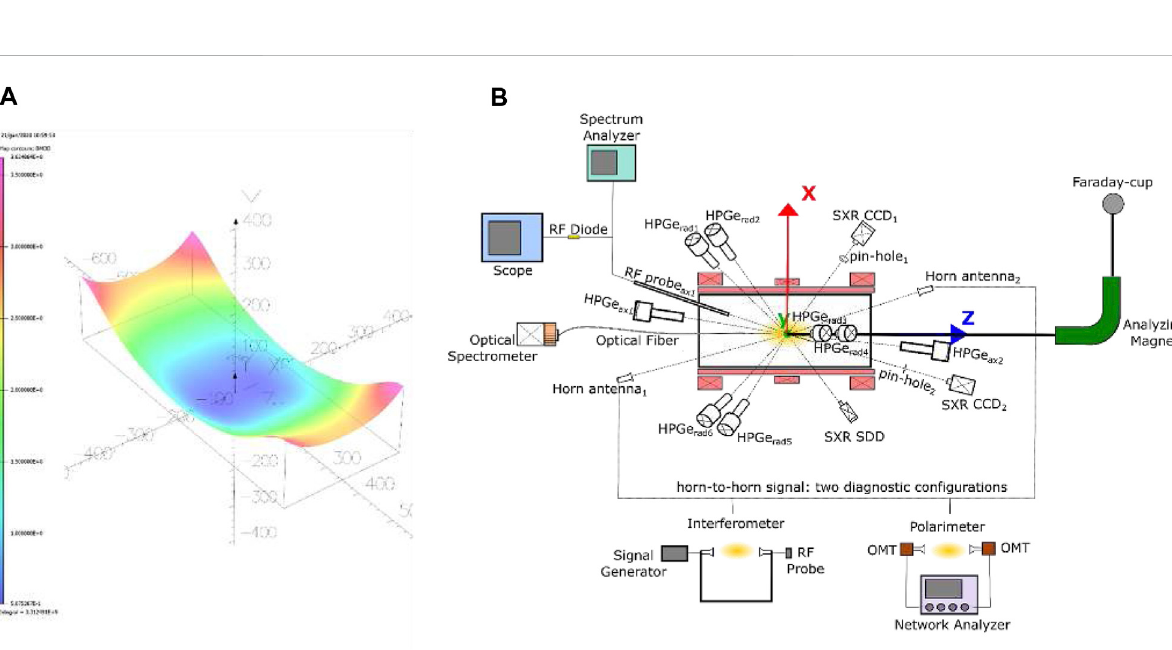
processing. In Section 4 polarimetric measurements performed in a free- space setup by using a rotating wire-grid polarizer and Ka-band